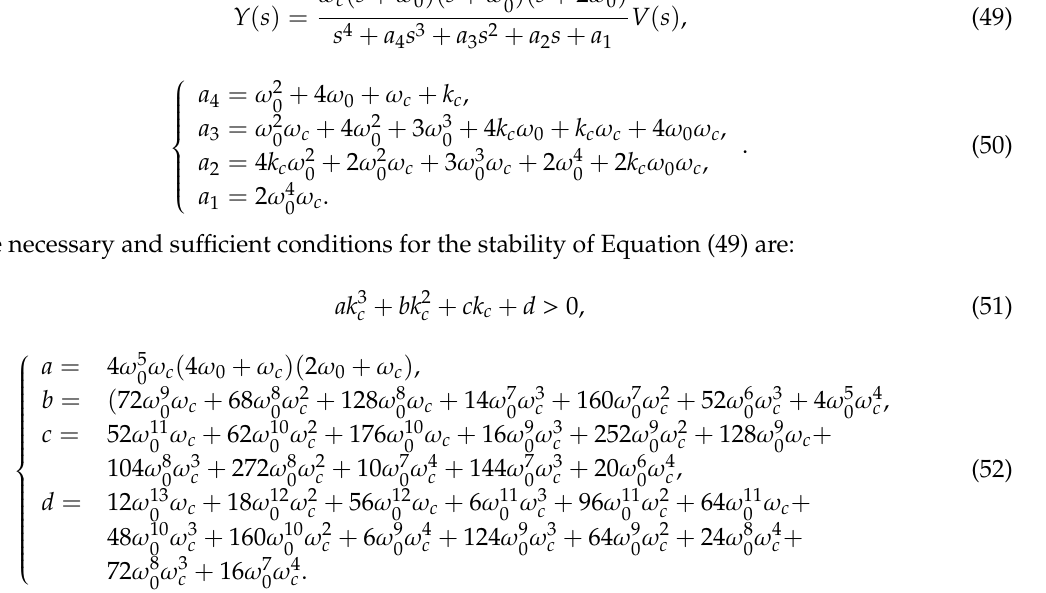
Figure 13. System stability region under different controller bandwidth